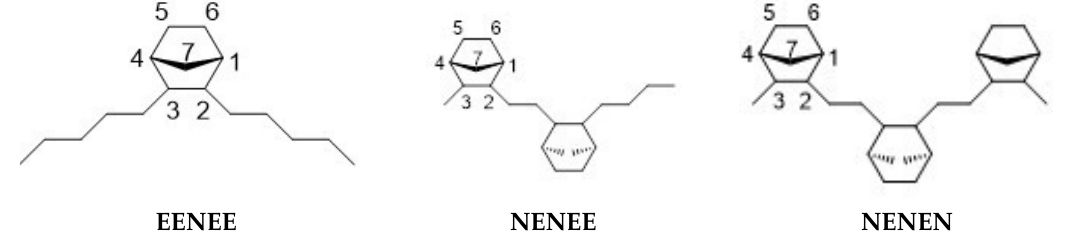
Scheme 5. Examples of segments of E- co -N copolymer chain at pentad